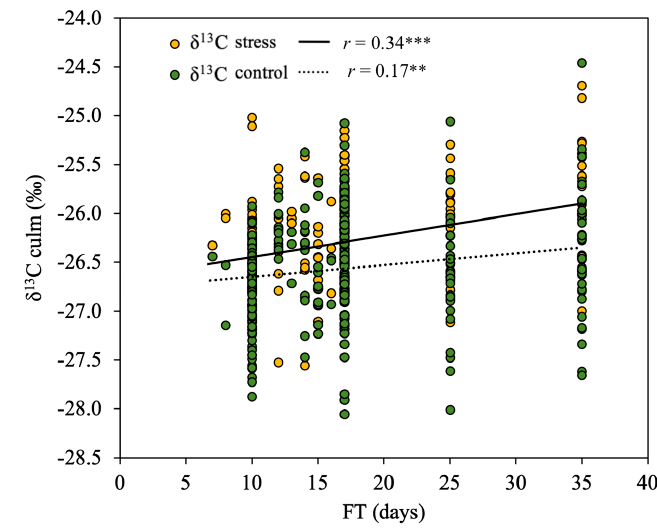
Figure 6. Linear regression of the relationship of the stable carbon isotope composition ( δ 13 C) of the flag leaf dry matter (DM) sampled before stress conditions were imposed ( δ 13 C control) and two weeks after the last irrigation ( δ 13 C stress) against the different categories of flowering times (FT) assessed as days from the earliest genotypes and included in the panel of 248 genotypes. The raw values of 0 FT are not included. Level of significance, ** p < 0.01, *** p < 0001.